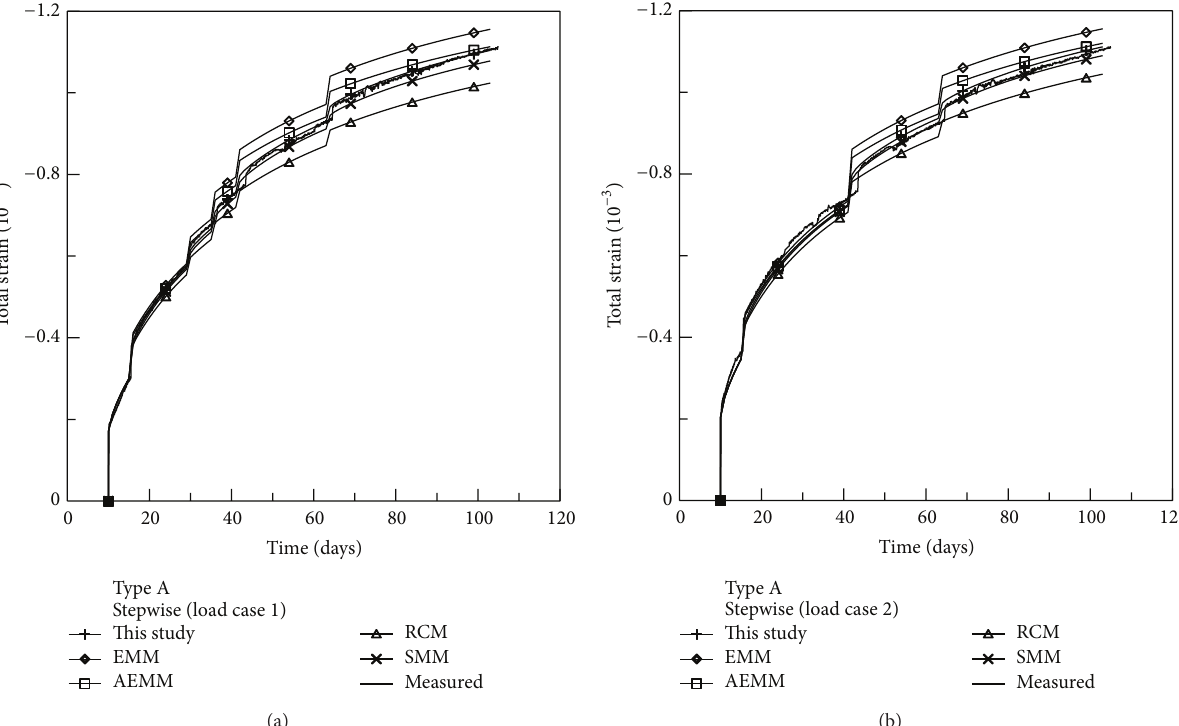
Figure 10: Comparison of the total strain predicted by the five creep models (type A test): (a) load case 1 and (b) load case 2.